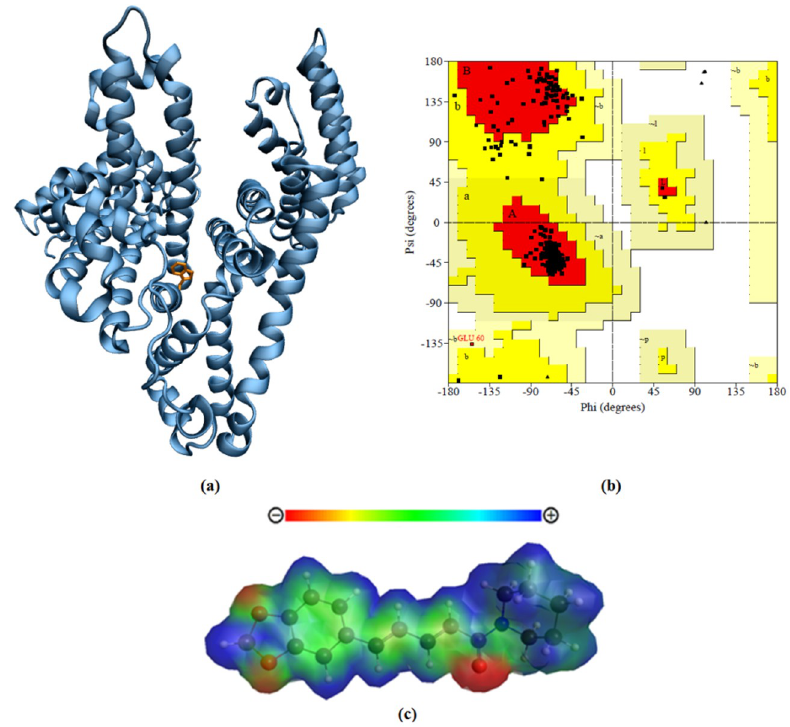
Figure 8. ( a ) RSA structure by comparative modeling with highlight on tryptophan in orange, ( b ) Ramachandran’s plot for RSA model, and ( c ) piperine electrostatic potential map (MEP).